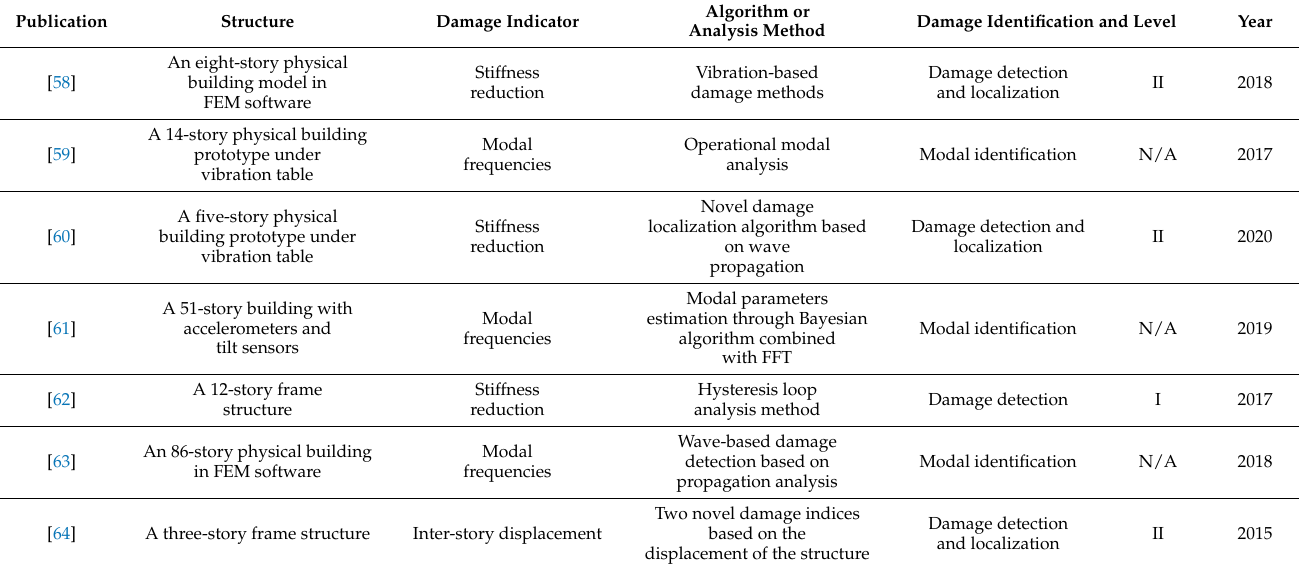
Table 6. N-story building structure health monitoring systems based on physical model